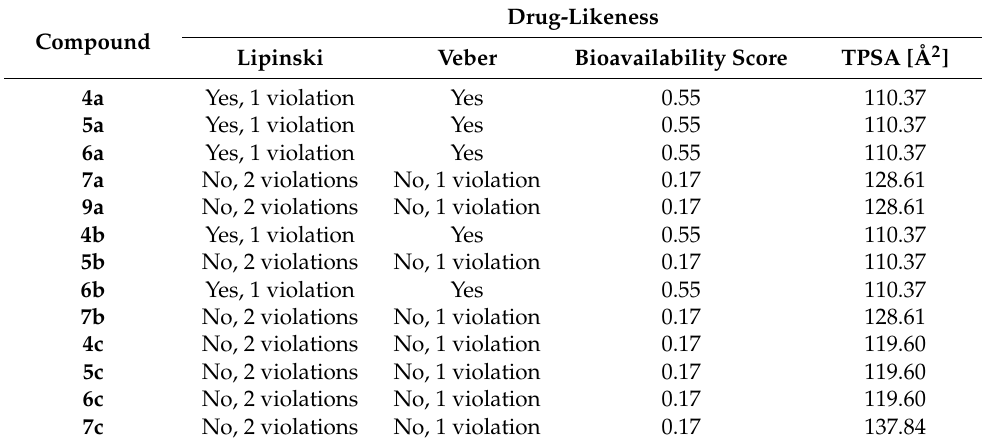
Table 11. Predicted drug-likeness properties of studied compounds using SWISSADME